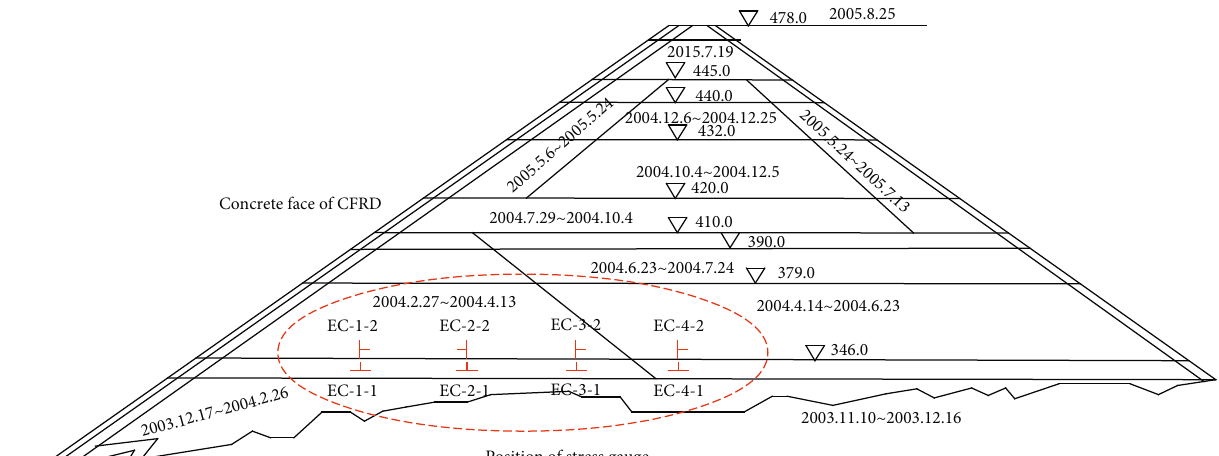
Figure 6: Filling process and stress gauge location of typical section of Sanbanxi Rockfill Dam (data from [21]).